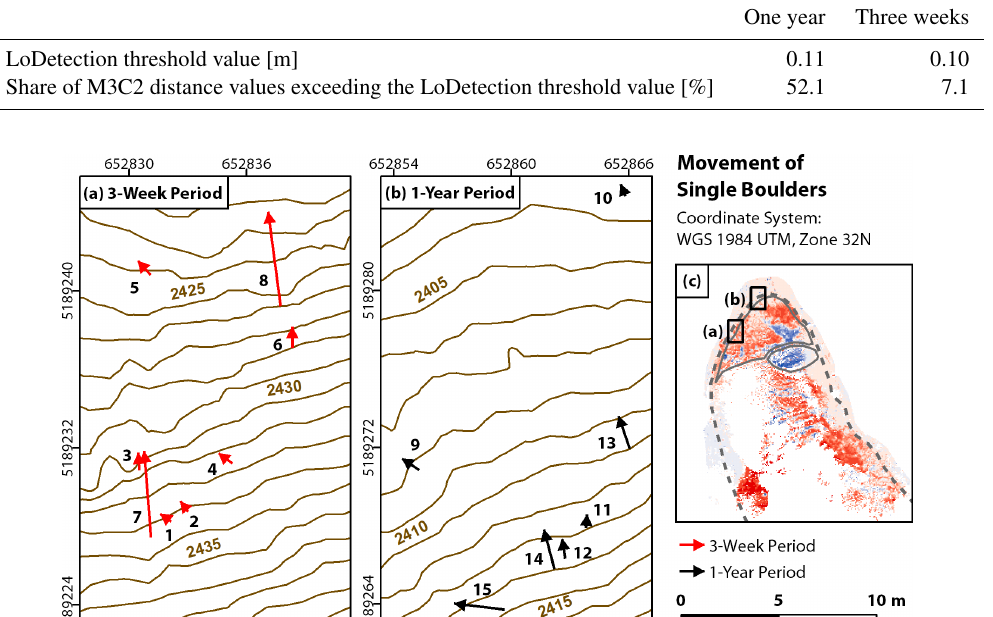
Table 1. Level of detection (LoDetection) threshold values and percentage of M3C2 distance values exceeding these thresholds during the 1-year period and during the 3-week period.